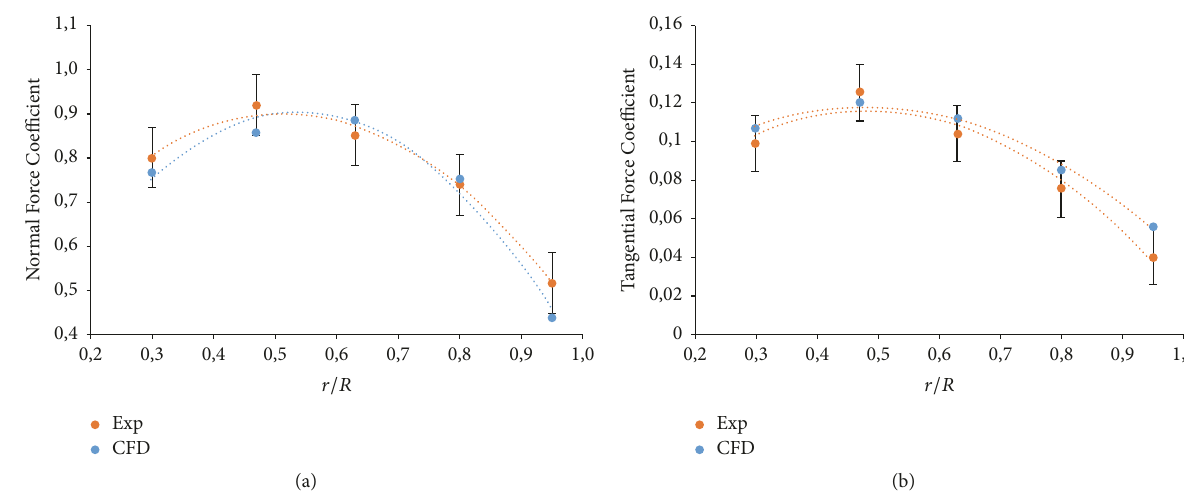
Figure 6: Normal (a) and tangential (b) force